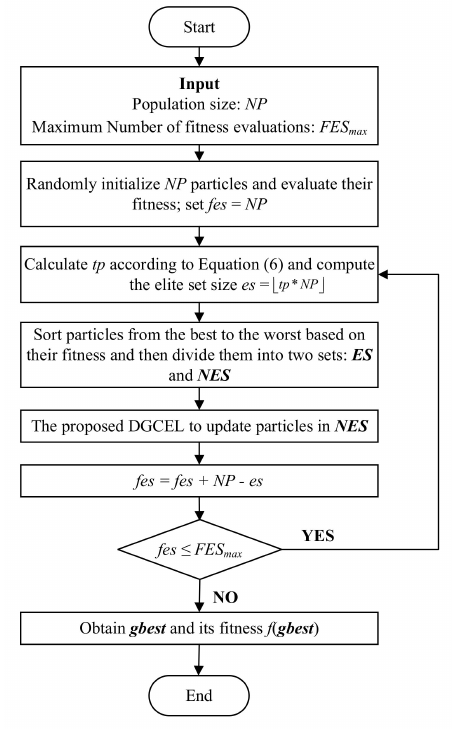
Figure 2. Flowchart of the proposed DGCELSO.